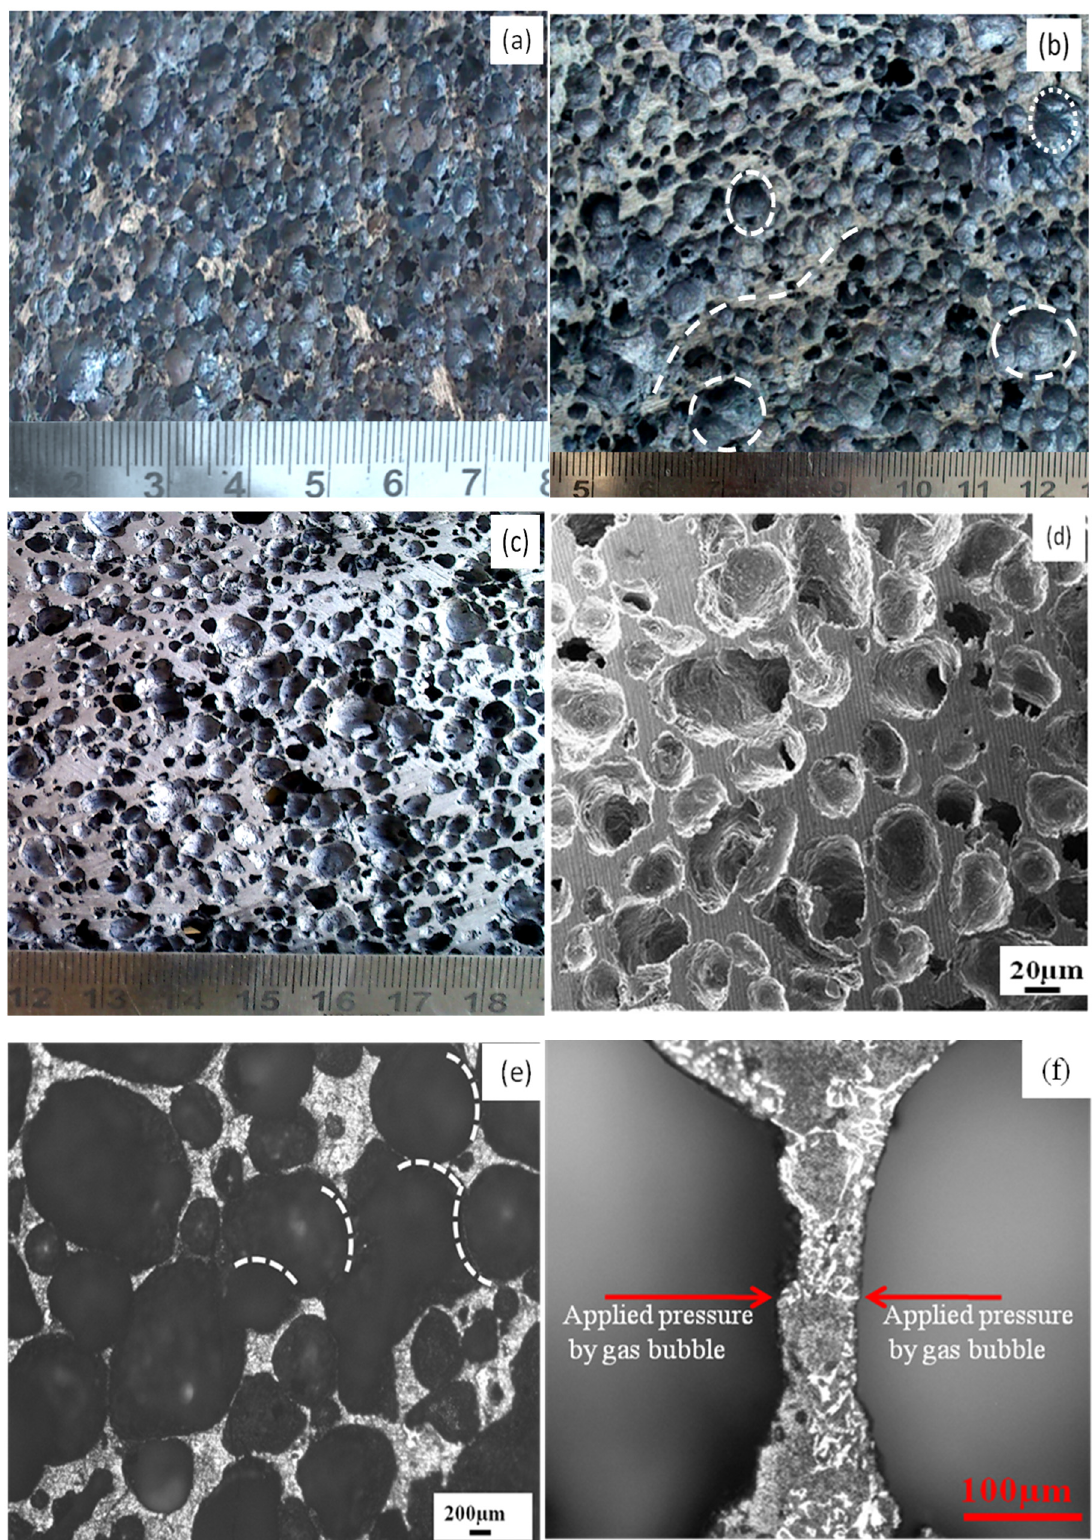
Figure 3. The images of aluminum alloy foam with 2 wt.% blowing agent CaCO 3 at ( a ) 850 °C, ( b ) 875 °C, ( c ) 900 °C, ( d ) SEM image of 850 °C foam and ( e ) and ( f ) optical image of LM13 alloy foam of 850 °C.